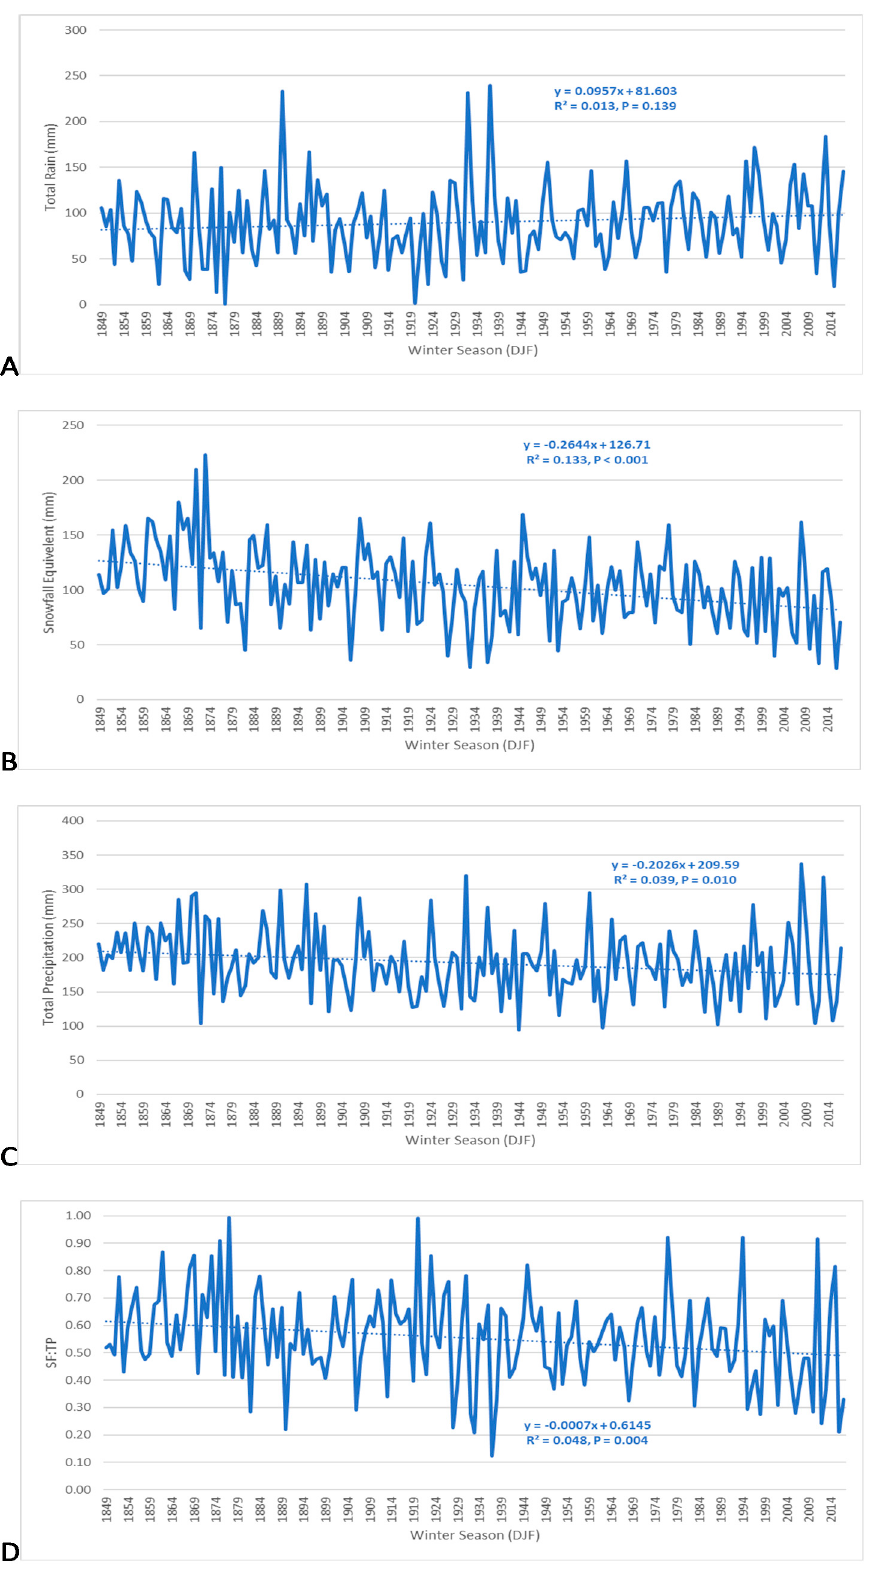
Figure 1. Trends in a ) rainfall, b ) snowfall equivalent, c ) total precipitation, and d ) ratio of snowfall to total precipitation (SF:TP), for winters in Toronto (1849–2017).